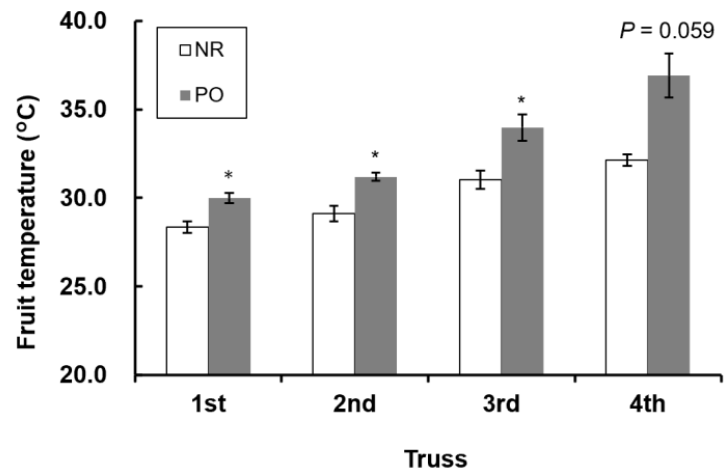
Figure 5. Fruit temperature of the first to fourth trusses of tomatoes grown in high tunnels covered with NR or PO. Mean values at each truss number from three plants ± SE are shown. * Significantly different from PO, as determined by an independent Student’s t -test: p < 0.05.